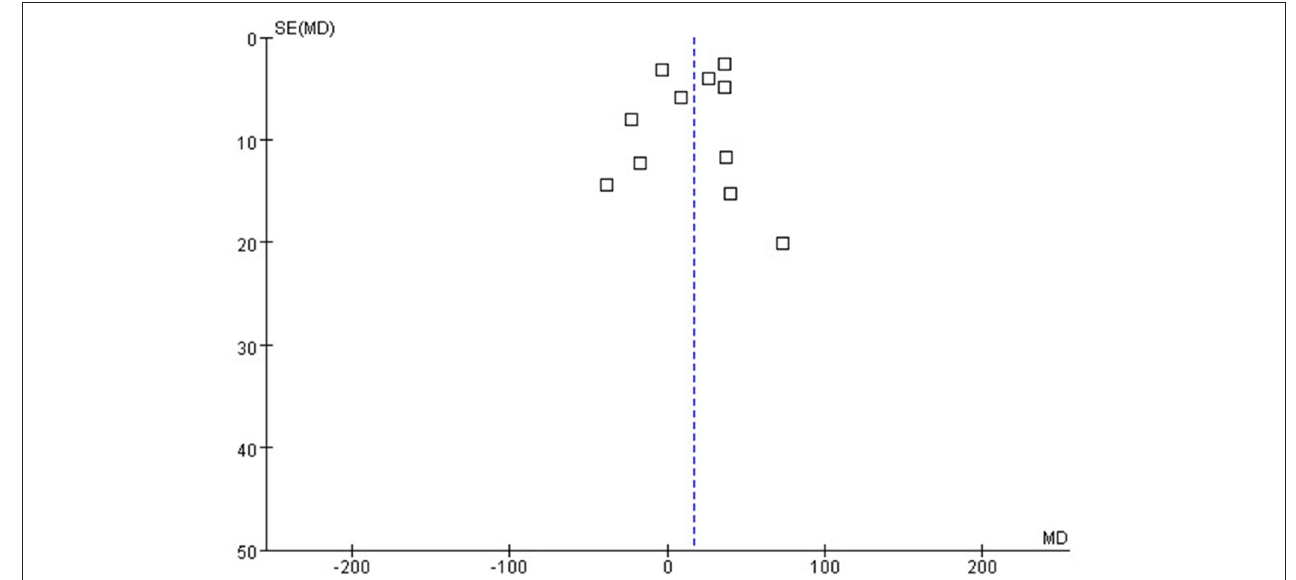
FIGURE 5 | The Funnel